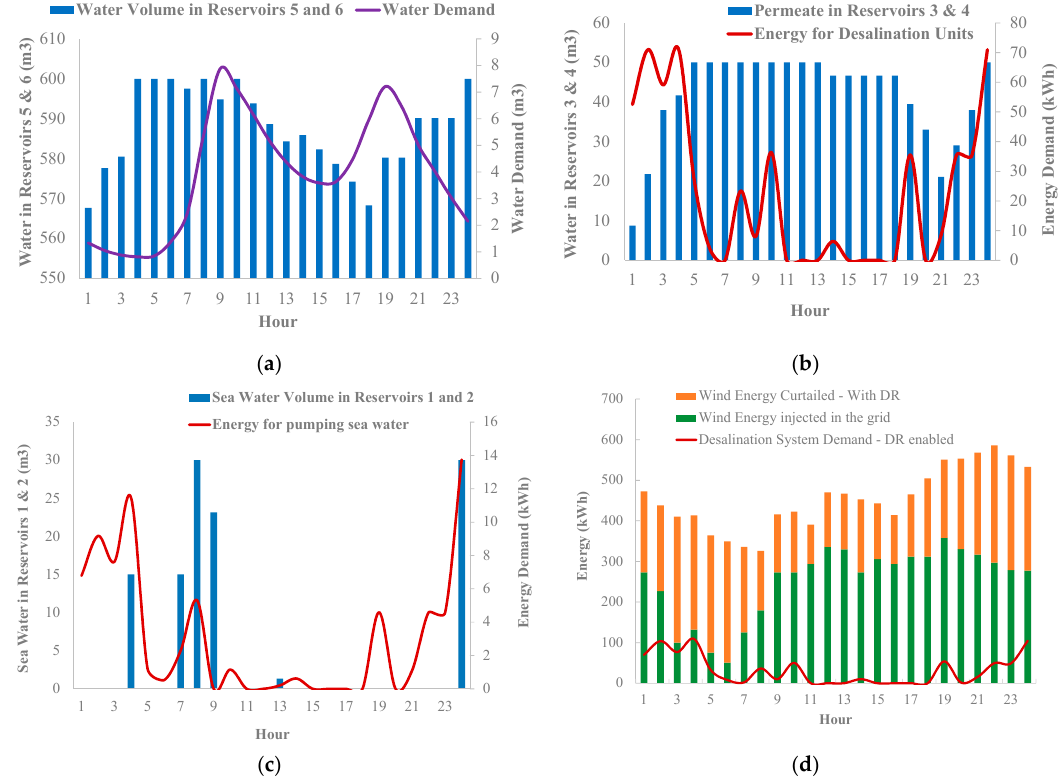
Figure 7. “Smart” operation of the desalination system for the first day of the examined year: ( a ) Volume of water in the clear water reservoirs and the relevant water demand, ( b ) energy demand of the desalination units and volume of permeate water, ( c ) energy demand for pumping sea water and the relevant volume of sea water in reservoirs 1 & 2, ( d ) Curtailment of the wind production & desalinations system demand.